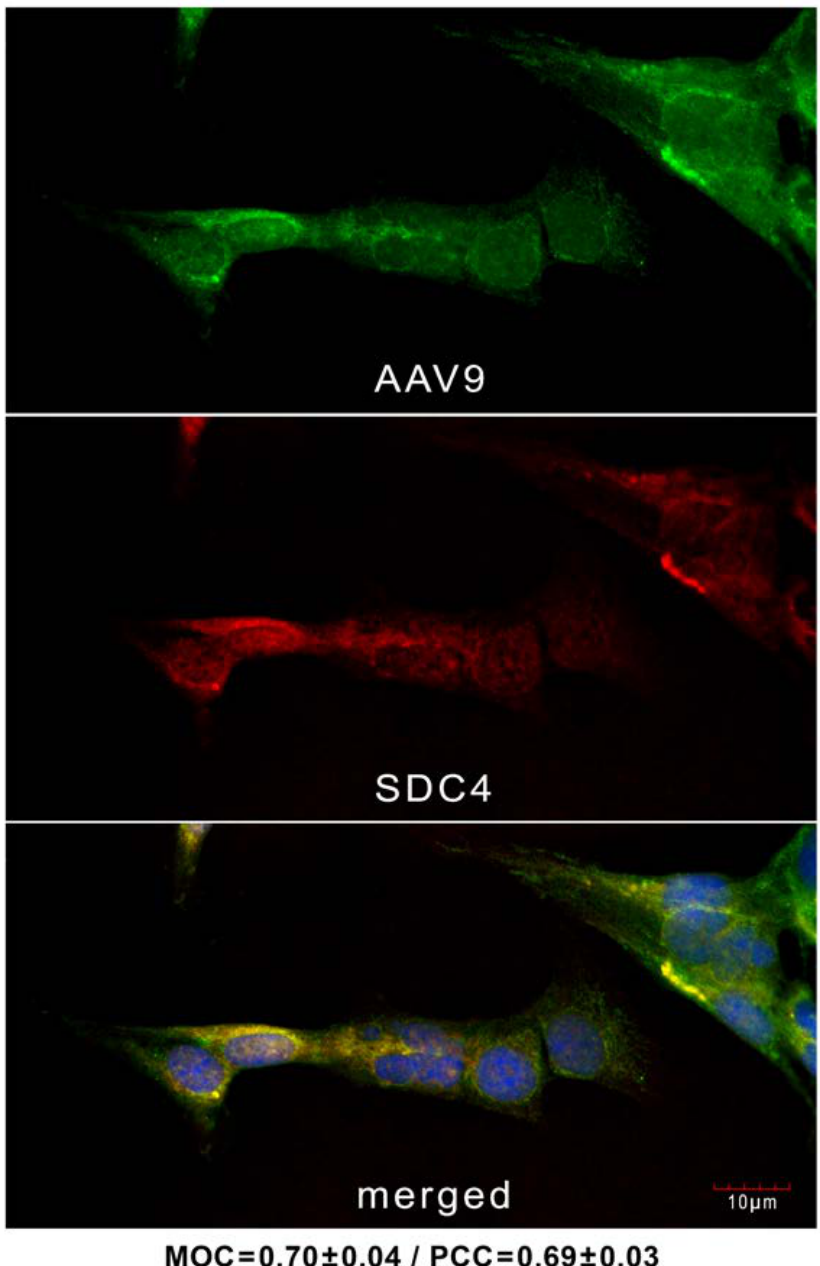
Figure 2. AAV9 colocalizes with SDC4 during cellular internalization. hCMEC/D3 cells were incubated with AAV9 (4 × 10 4 vg/cell) for 6 h at 37 ◦ C. The cells were then trypsinized, fixed, permeabilized and treated with AF488-labeled AAV9 (green) and APC-labeled SDC4 (red) antibodies. AAV9’s colocalization with SDC4 was analyzed with confocal microscopy. Representative images of three independent experiments are shown. Scale bar = 10 µ m. The MOC ± SEM and PCC ± SEM for the overlap and colocalization of SDC4 with AAV9 are indicated below the images.